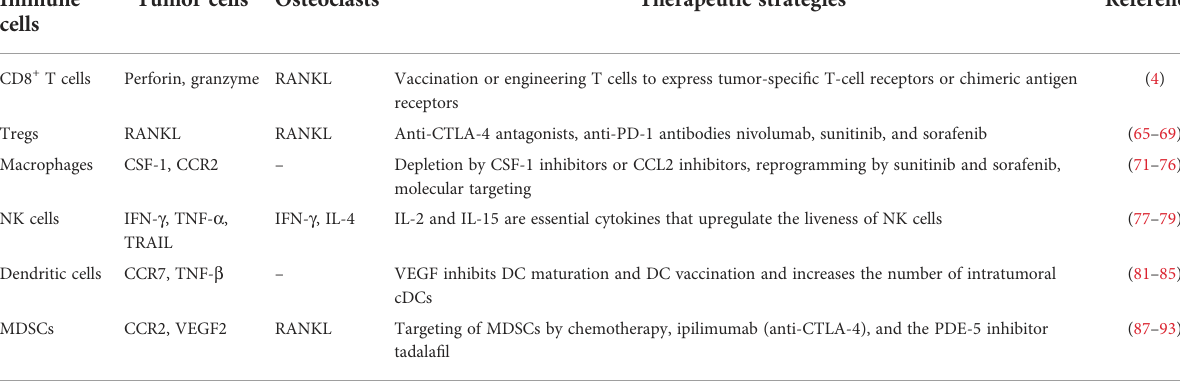
TABLE 1 The interaction of immune cells, tumor cells, and osteoclasts in the bone microenvironment and their therapeutic strategies. Immune Tumor cells Osteoclasts Therapeutic cells